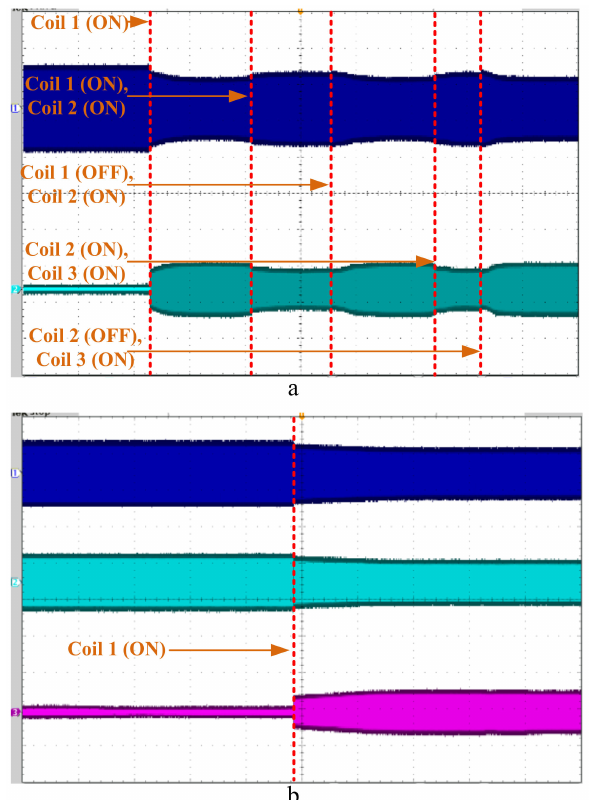
Figure 15. The characteristic curves of the receiving power of multiple loads varying with the position of the new accessing load. ( a ) The accessing process of the second load (CH1 (25 V/div): voltage of the first load. CH2 (25 V/div): voltage of the second load.); ( b ) The accessing process of the third load. (CH1 (25 V/div): voltage of the first load. CH2 (25 V/div): voltage of the second load. CH3 (25 V/div): voltage of the third